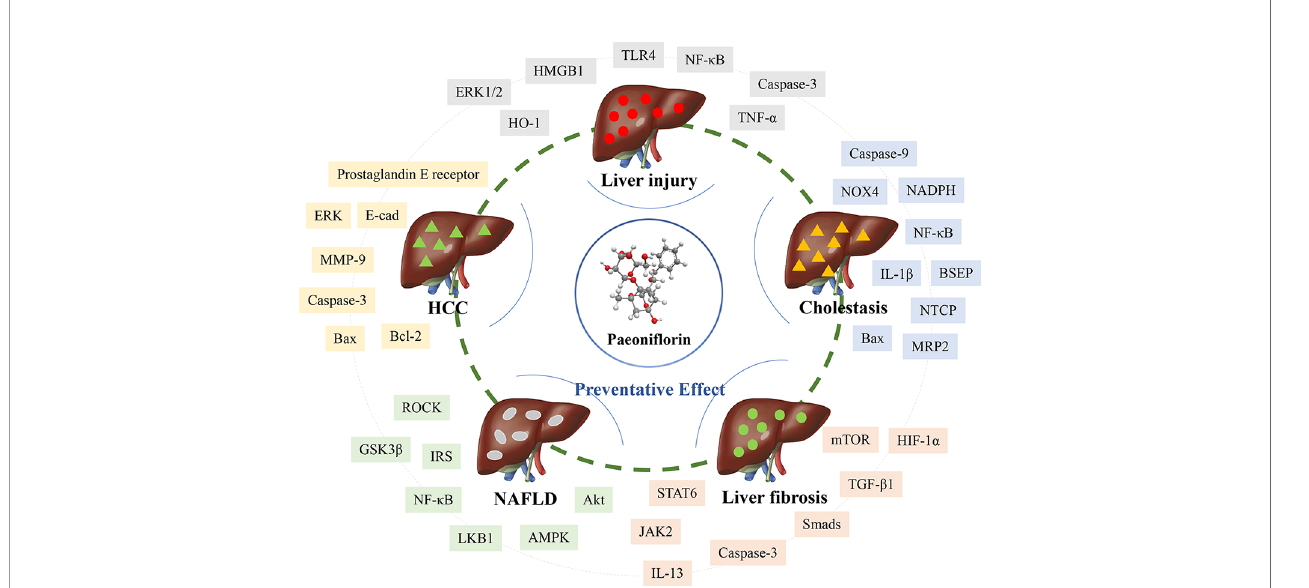
FIGURE 1 | The pharmacological effect of paeoni fl orin on liver diseases through multiple